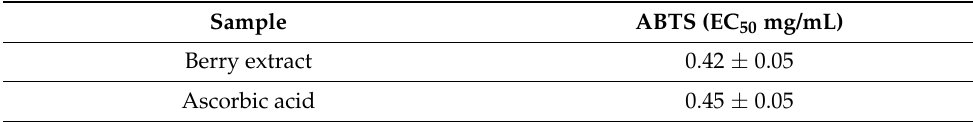
Table 2. Antioxidant activity of the dry Amelanchier ovalis berry